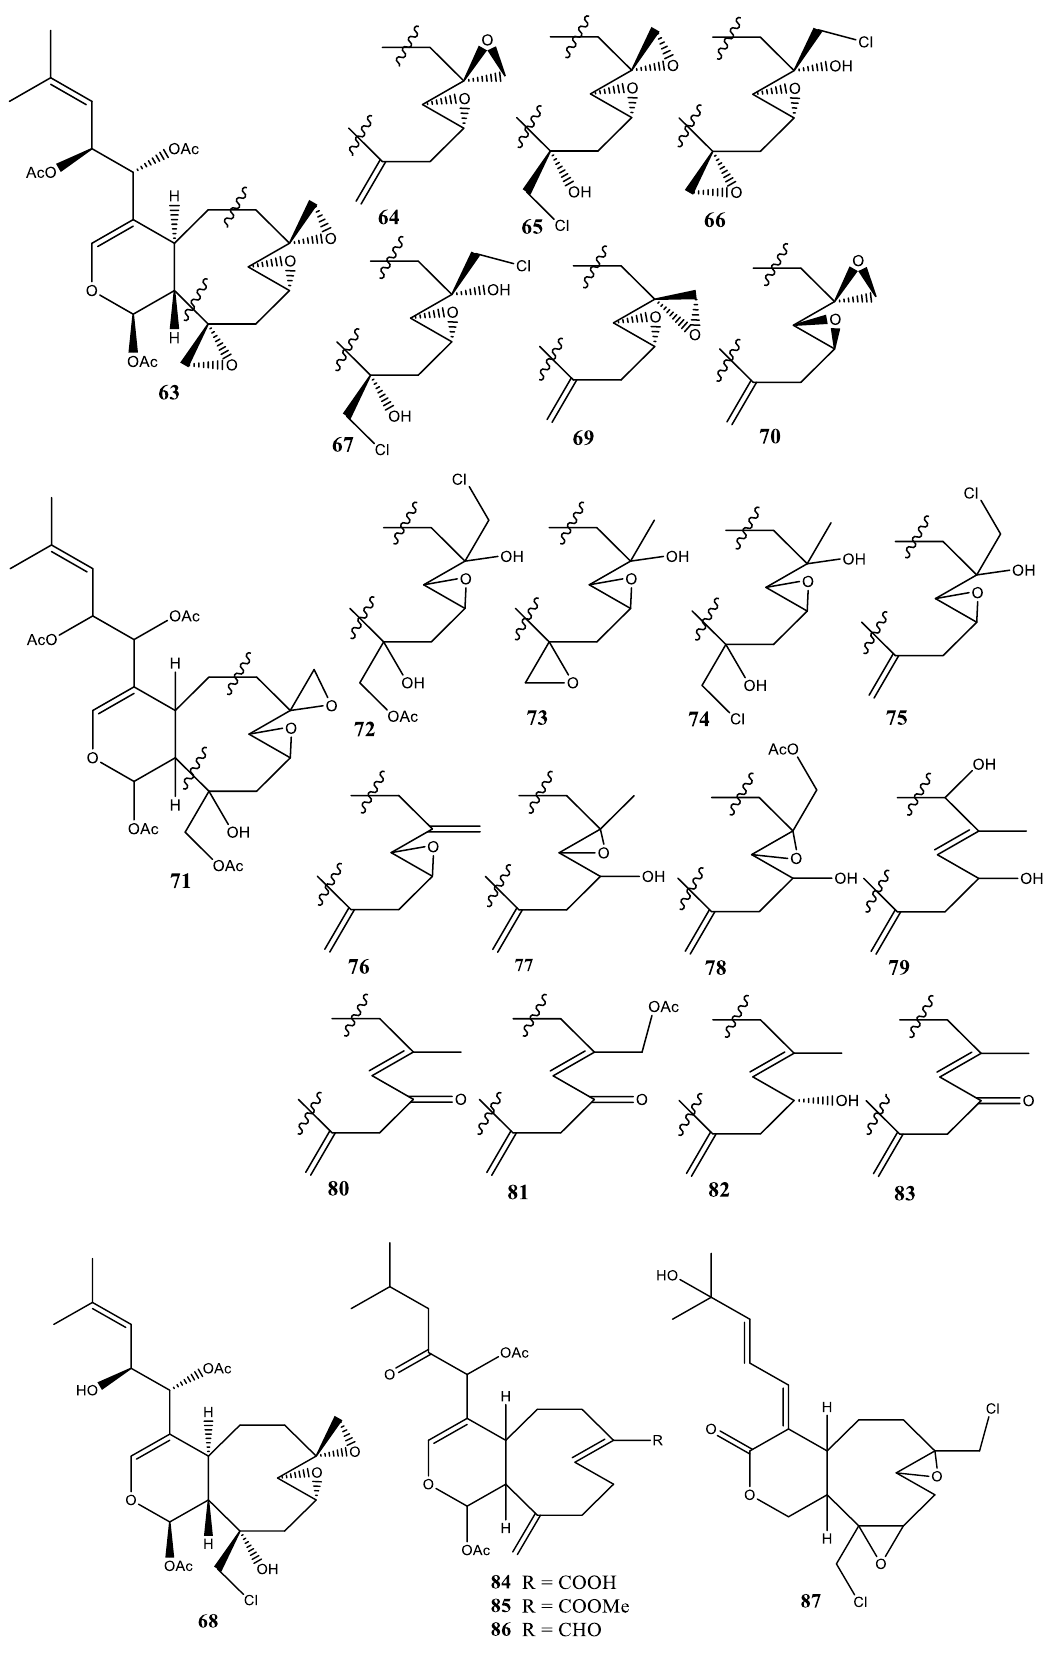
Figure 5. Structures of compounds 63 – 87 .